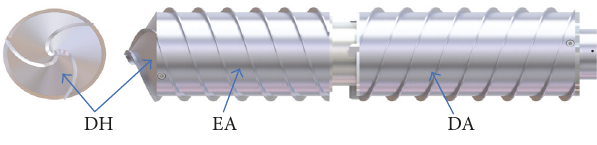
Figure 10: Tools: DH, EA, and